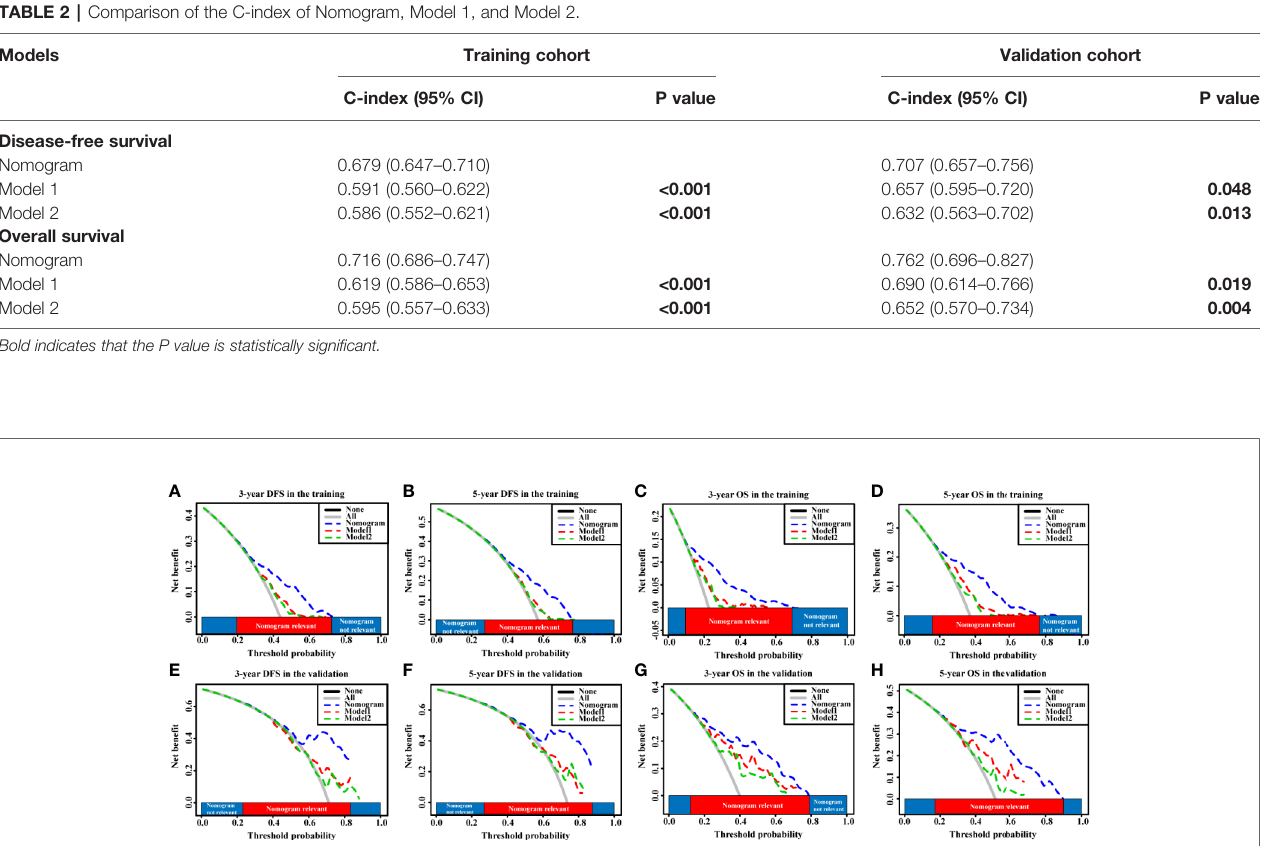
TABLE 2 | Comparison of the C-index of Nomogram, Model 1, and Model 2. Models